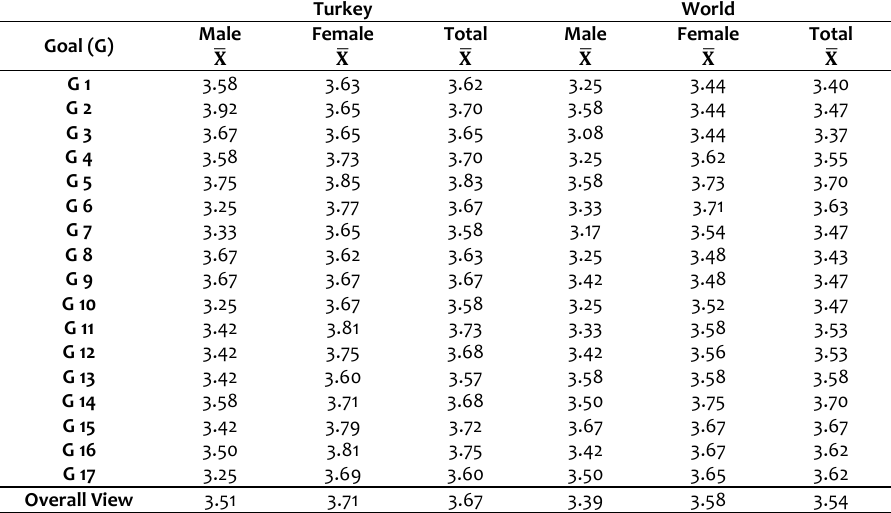
Table 1. Pre-service Male and Female Teachers’ Status of Caring about the UN 2030 SDG for Turkey and for the World Turkey World Goal